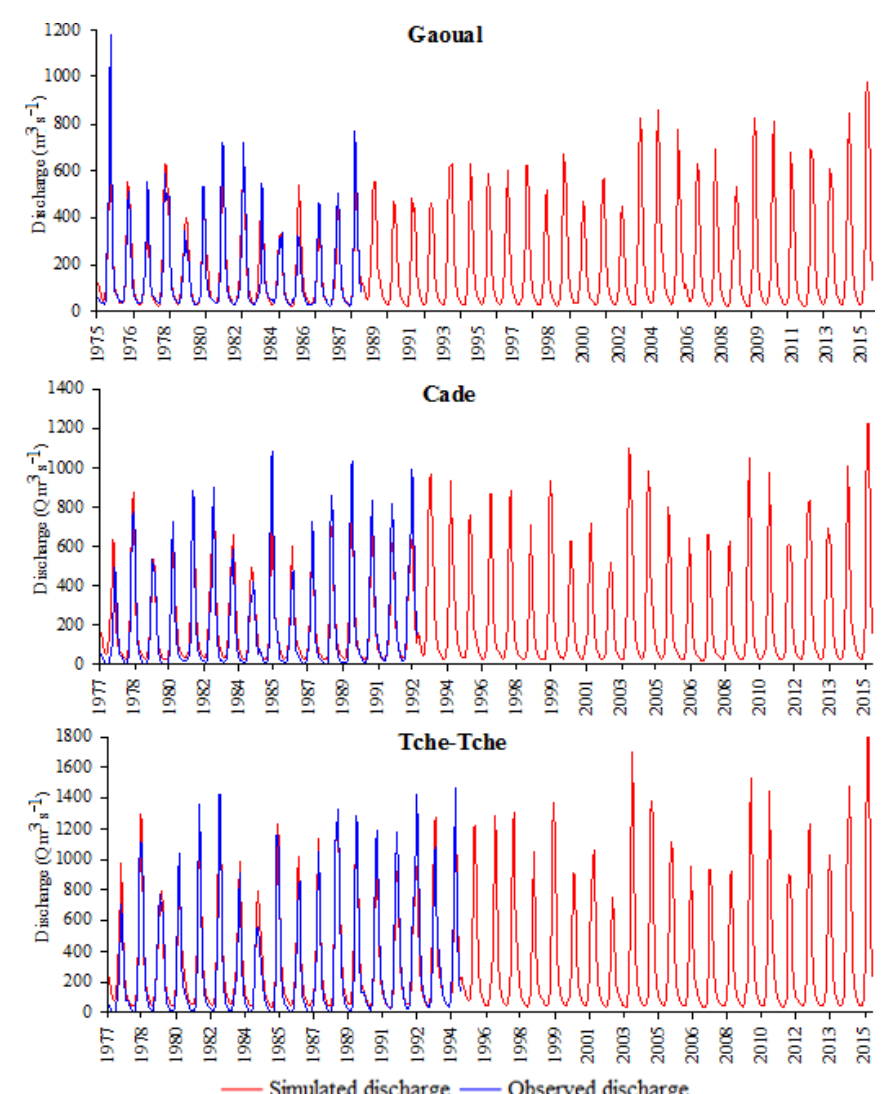
Figure 10. Comparison of observed and simulated monthly discharge.